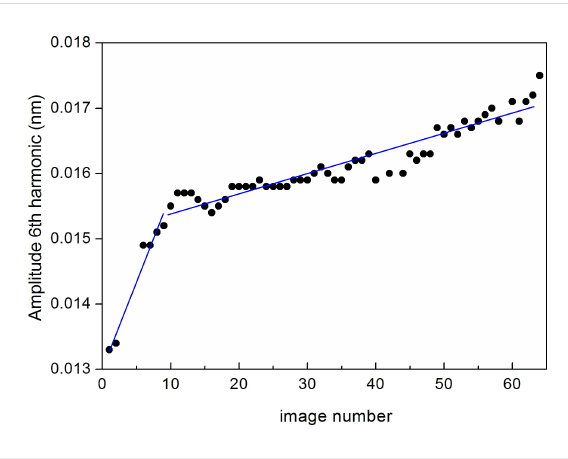
Figure 5: (color online) Evolution of the mean value of the amplitude of the 6th harmonic extracted from the amplitude image simultaneously acquired with the topography and phase images. Experiments have been performed with a nominally 44 N/m rectangular AFM cantilever with resonance frequency 350 kHz on silicon surfaces under ambient conditions. The time evolution is expressed in terms of sequentially acquired images. The free oscillation amplitude was set to 30 nm and setpoint to A sp = 27 nm, respectively. The missing points 3, 4 and 5 correspond to approach curves taken for amplitude calibration. The continuous blue lines are guides to the eye.